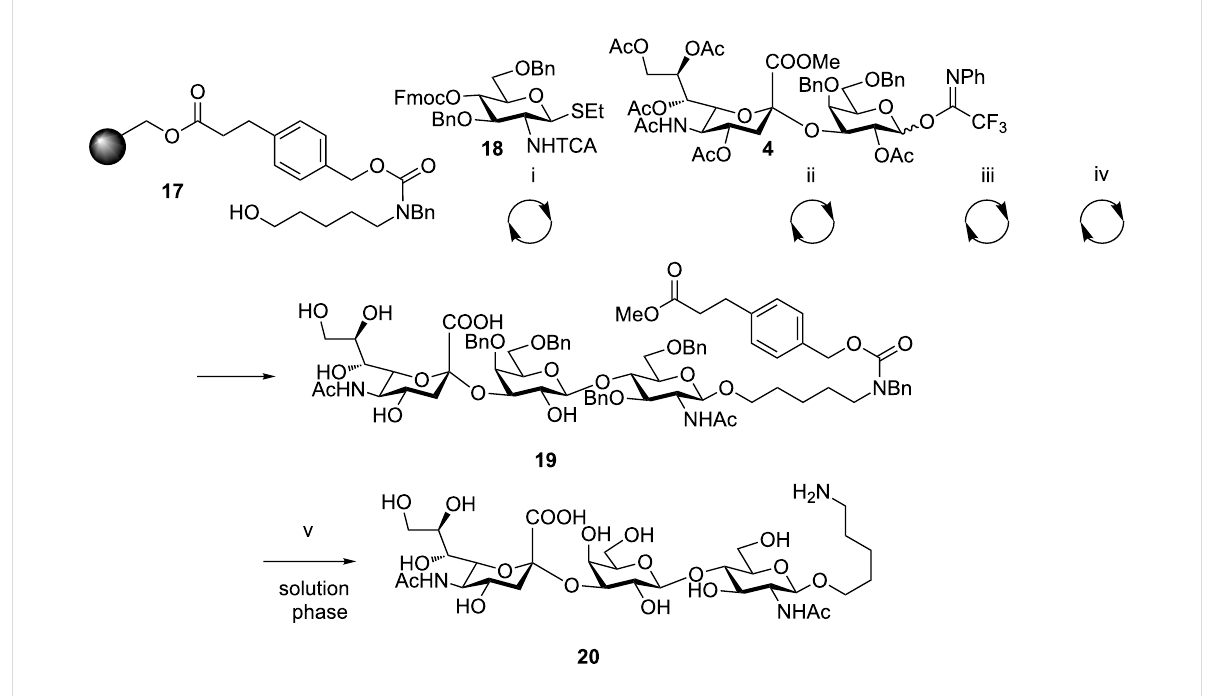
Scheme 3: Automated synthesis of 20 . Reagents and conditions: (i) (a) NIS, TfOH, dioxane, DCM, − 40 to − 20 °C, 40 min; (b) piperidine, DMF. (ii) (a) TMSOTf, DCM, 0 °C, 2 h; (b) piperidine, DMF. (iii) AIBN (cat.), Bu 3 SnH (10 equiv), xylene, 90 °C. (iv) NaOMe, MeOH, DCM, 1.5 h, 33%. (v) Pd/C, H 2 , MeOH/H 2 O, cat. AcOH, 78% (for experimental details see the supporting information of [5]).